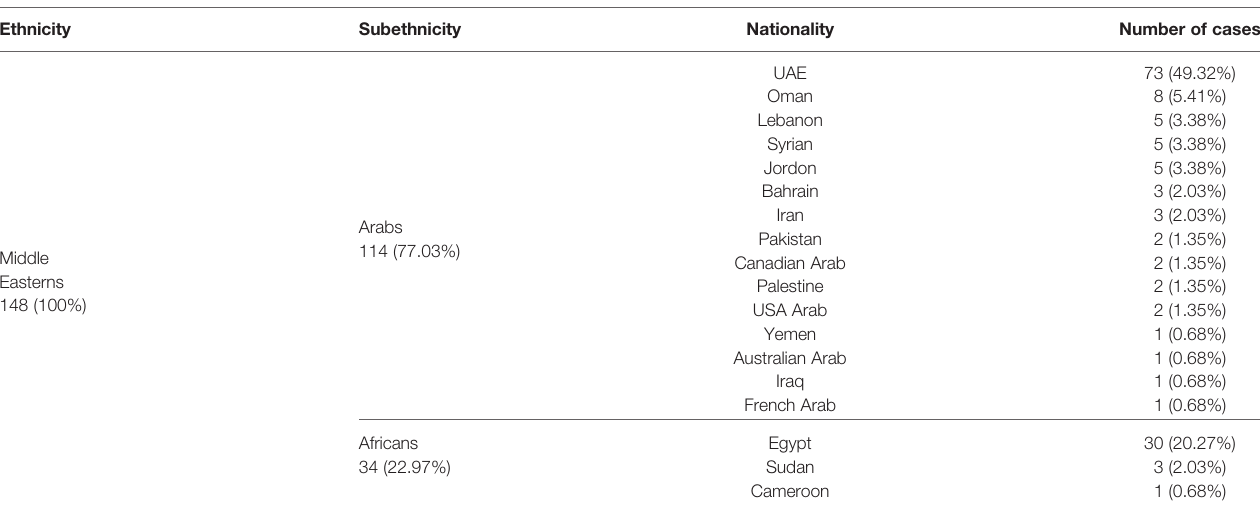
TABLE 2 | Nationalities of Middle Eastern ethnic